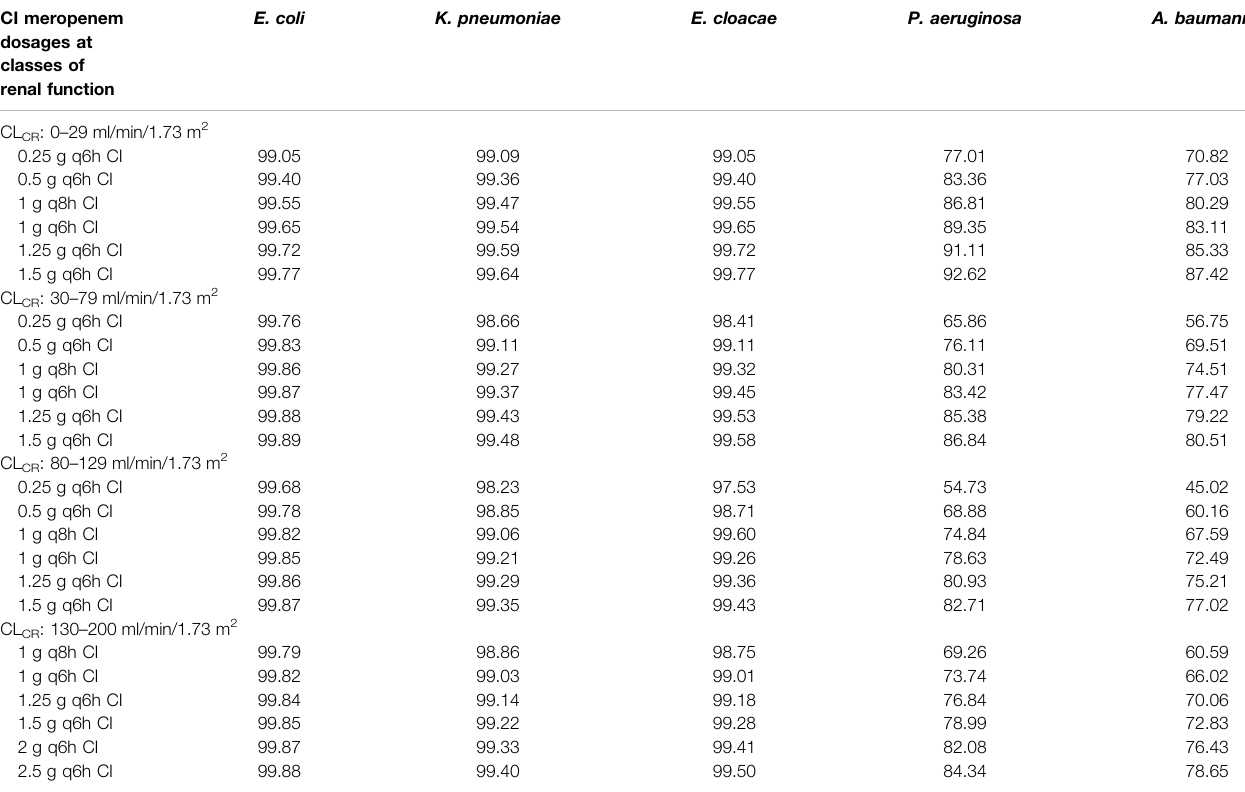
TABLE 5 | Cumulative fraction of response (CFR) achievable with incremental dosages of continuous infusion (CI) meropenem at different classes of renal function for a pharmacodynamic target of plasma steady-state (Css)/minimum inhibitory concentration (MIC) ratio of 4.63 against the EUCAST MIC distribution of Escherichia coli , Klebsiella pneumoniae , Enterobacter cloacae , Pseudomonas aeruginosa and Acinetobacter baumannii